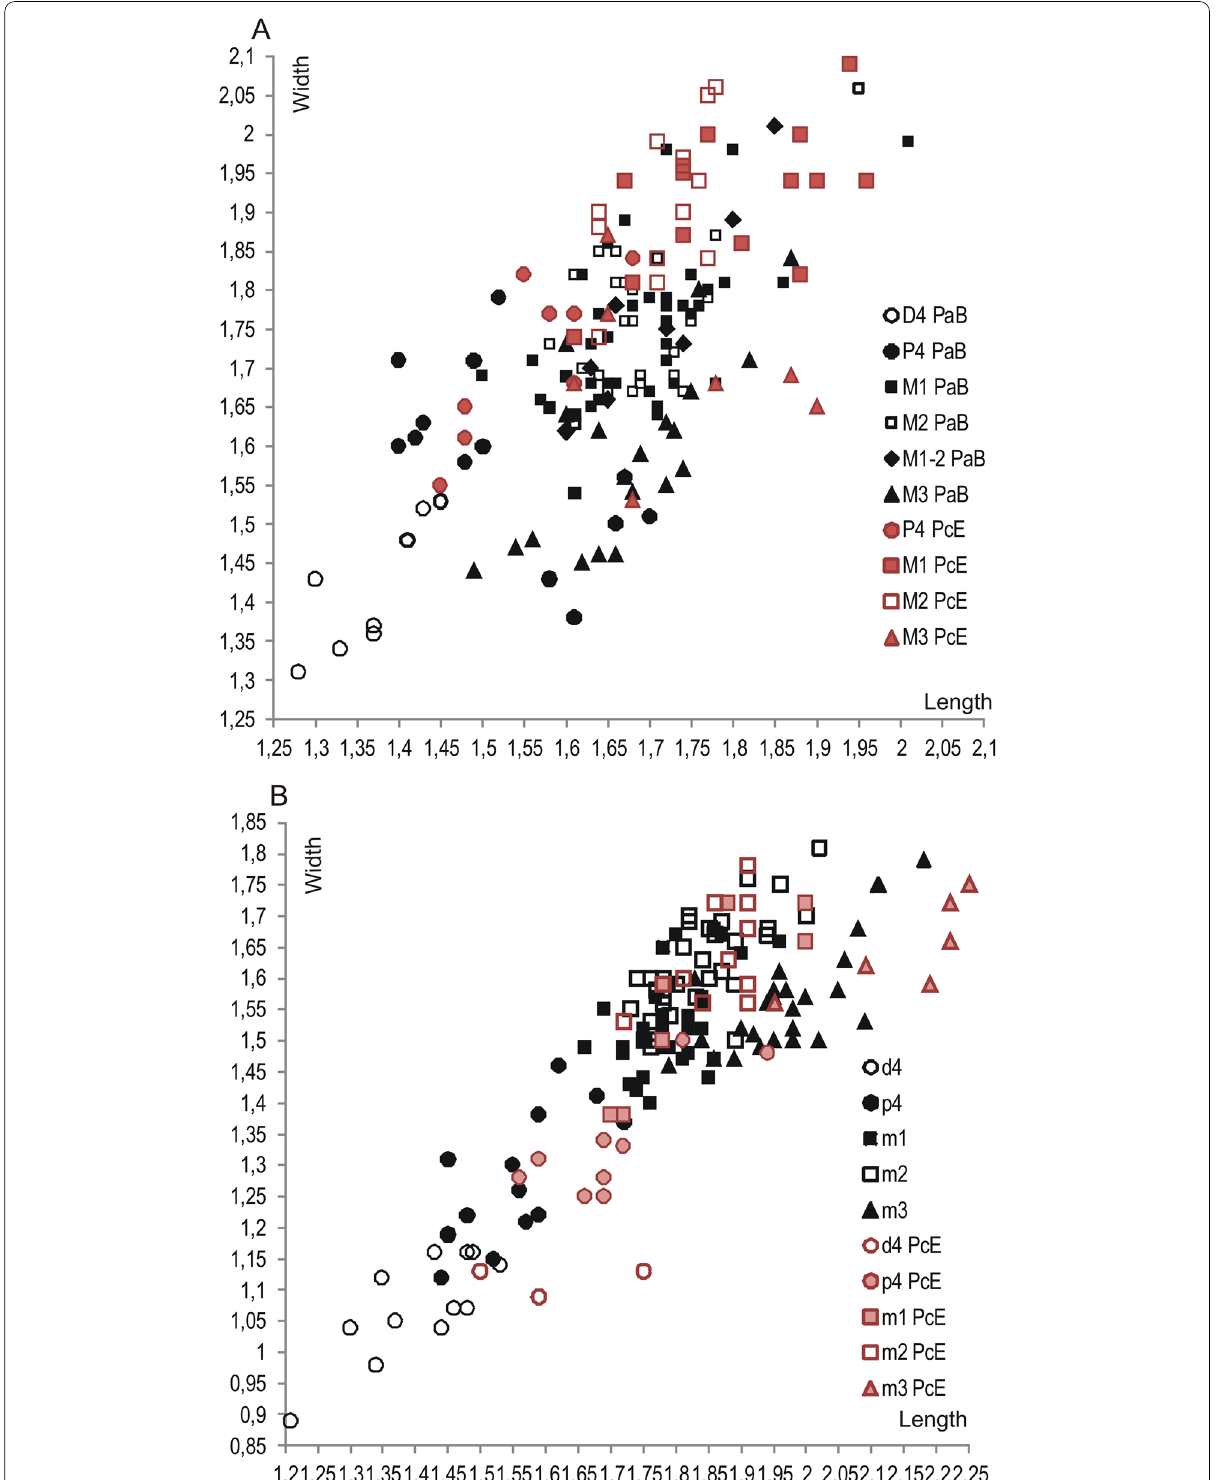
Fig. 28 Bivariate graph of the size (width/length) of the upper ( A ) and lower ( B ) teeth of ? Protadelomys alsaticus Hartenberger, 1969 from Bouxwiller (Bas‑Rhin) (black marks, PaB) compared to the size of the teeth of Protadelomys cartieri (Stehlin & Schaub, 1951), from Egerkingen (Swiss Jura) (red marks,